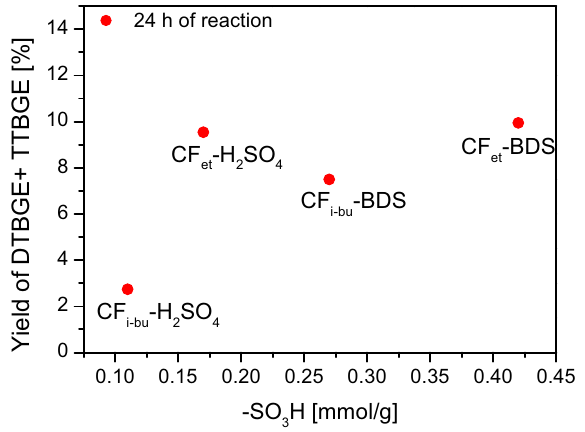
Figure 11. The influence of the content of sulfonic groups on the yield of DTBGE + TTBGE obtained in the etherification of glycerol with